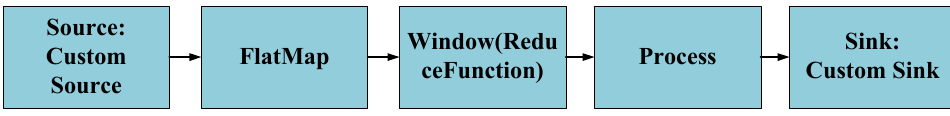
Figure 15. The pipeline of ItemMonitor with five operators chained in